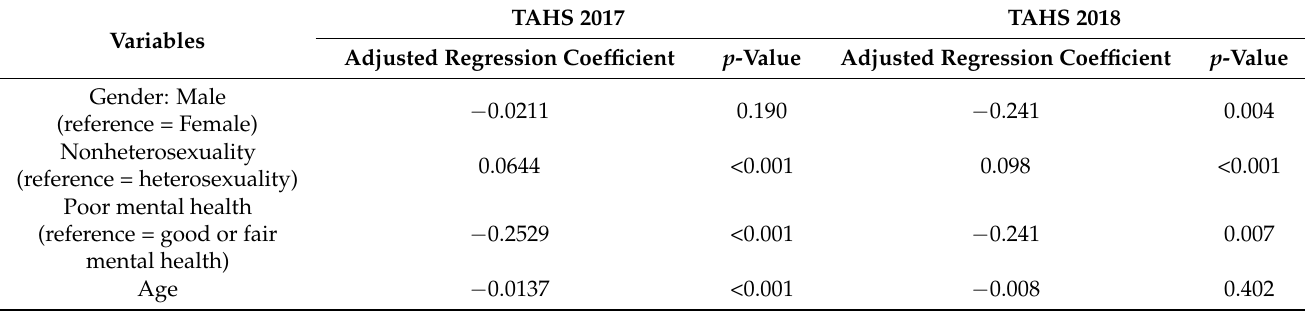
Table 3. Association of gender, sexual orientation, mental health, and age with perceived attitudes toward homosexuality in TAHS 2017 and TAHS 2018: multiple regression